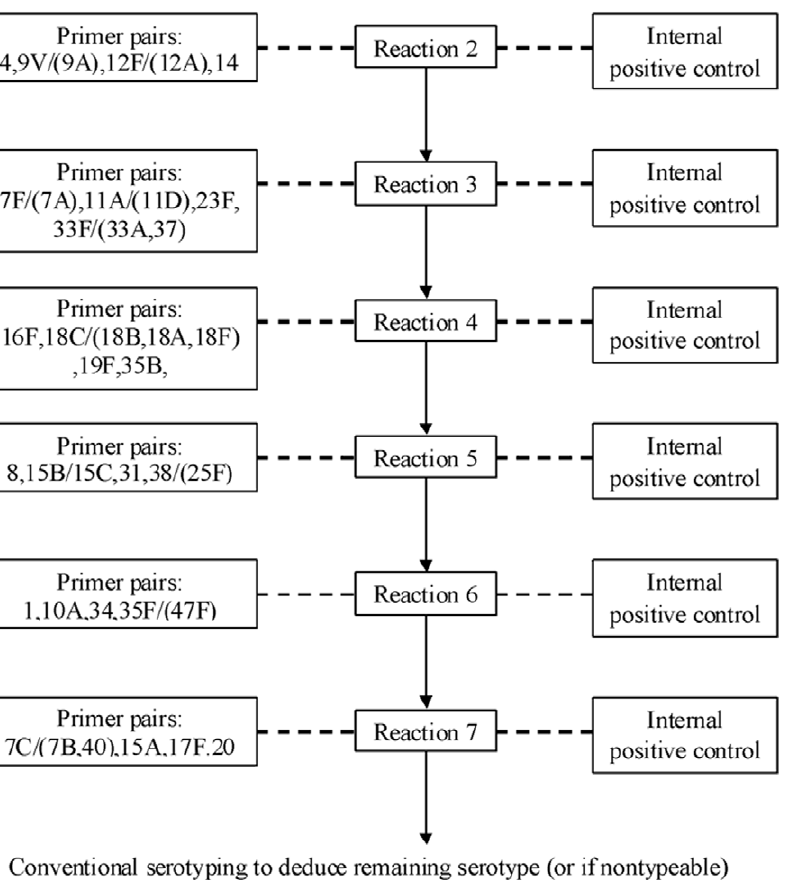
Figure 1. Sequential multiplex PCR approaches for pneumococcal capsular serotyping. Each of the seven reactions include five primer pairs, four of which targets four different serotypes and another primer pair serves as internal positive control.